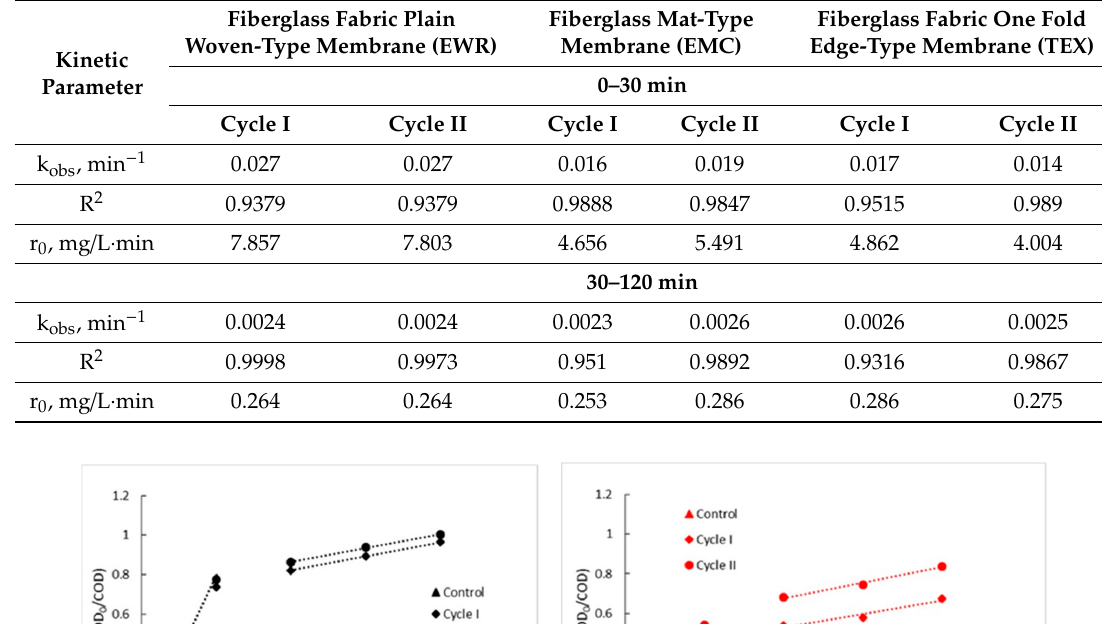
Table 3. Kinetic parameters of photocatalytic degradation.